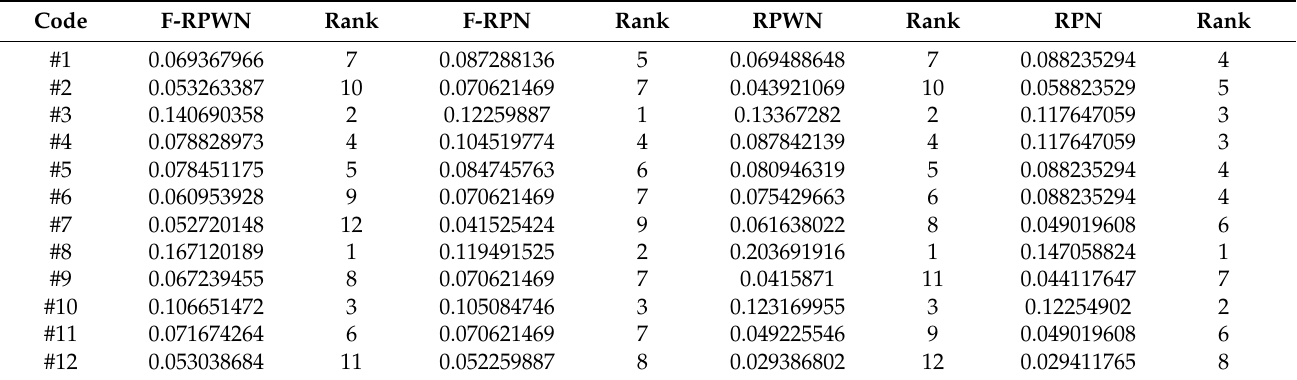
Table 9. Fuzzy FMEA-AHP, Fuzzy FMEA, FMEA-AHP, traditional FMEA ranking